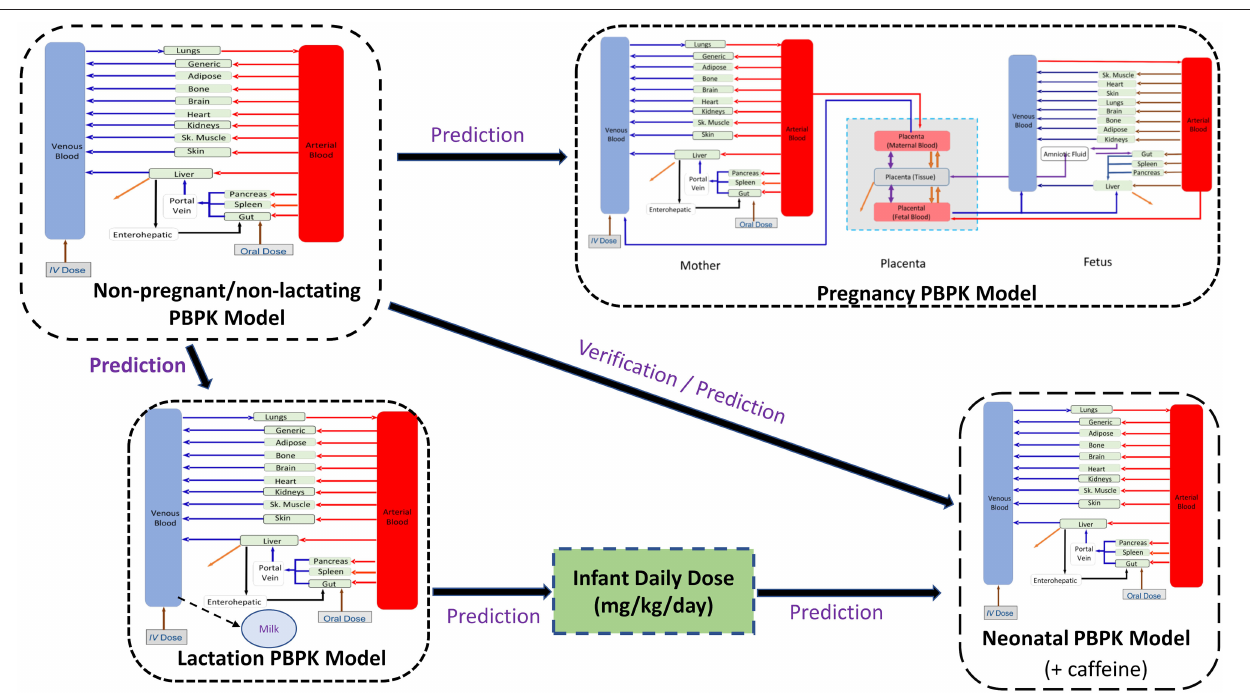
FIGURE 1 | Workflow of the implemented perinatal theophylline physiological-based pharmacokinetic (PBPK) model. The neonatal model includes caffeine PBPK as a formed